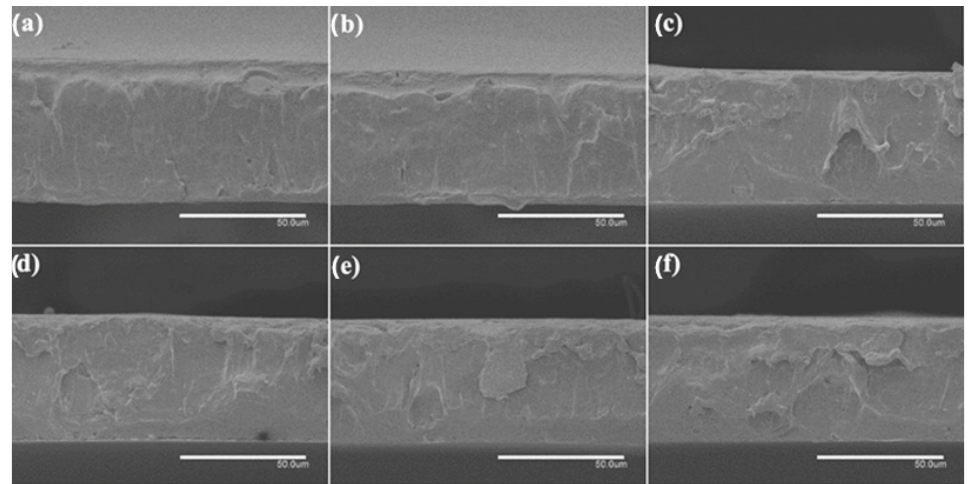
Figure 6. Comparison of the cross-section morphology for the electrospun poly(3-hydroxybutyrate- co-3-hydroxyvalerate) (PHBV) films: ( a ) 0.5 wt.% CeO 2 NPs; ( b ) 1.0 wt.% CeO 2 NPs; ( c ) 1.5 wt.% CeO 2 NPs; ( d ) 2.0 wt.% CeO 2 NPs; ( e ) 5.0 wt.% CeO 2 NPs; ( f ) 10.0 wt.% CeO 2 NPs. Images were taken by scanning electron microscopy (SEM). Scale bar corresponds to 50 µm. 10.0 wt.% CeO 2 NPs + CTAB. Images were taken by scanning electron microscopy (SEM). Scale bar 50 µm.